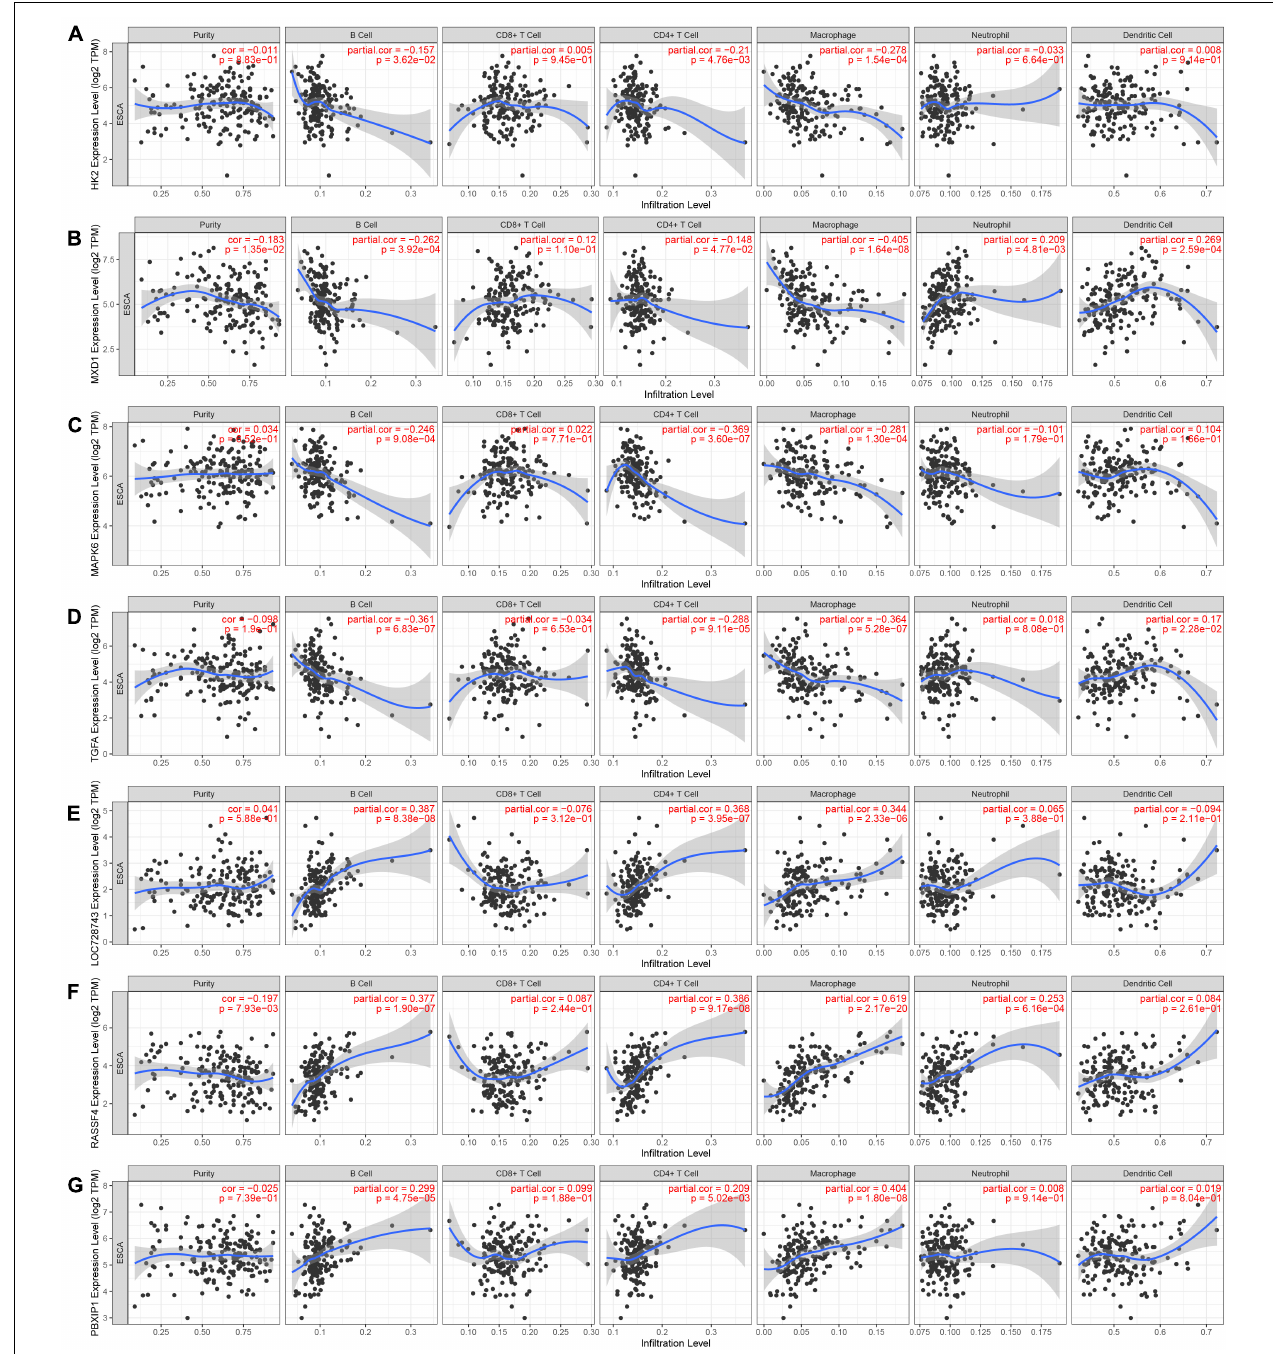
FIGURE 5 | Association between HK2 and tumor immune infiltrating cells. (A) Association between the expression of HK2 and the expression of immune infiltrating cell. Correlation between expression of HK2 co-expressed genes and expression in immune infiltrating cells, including MXD1 (B) , MAPK6 (C) , TGFA (D) , LOC728743 (E) , RASSF4 (F) and PBXIP1 (G) .